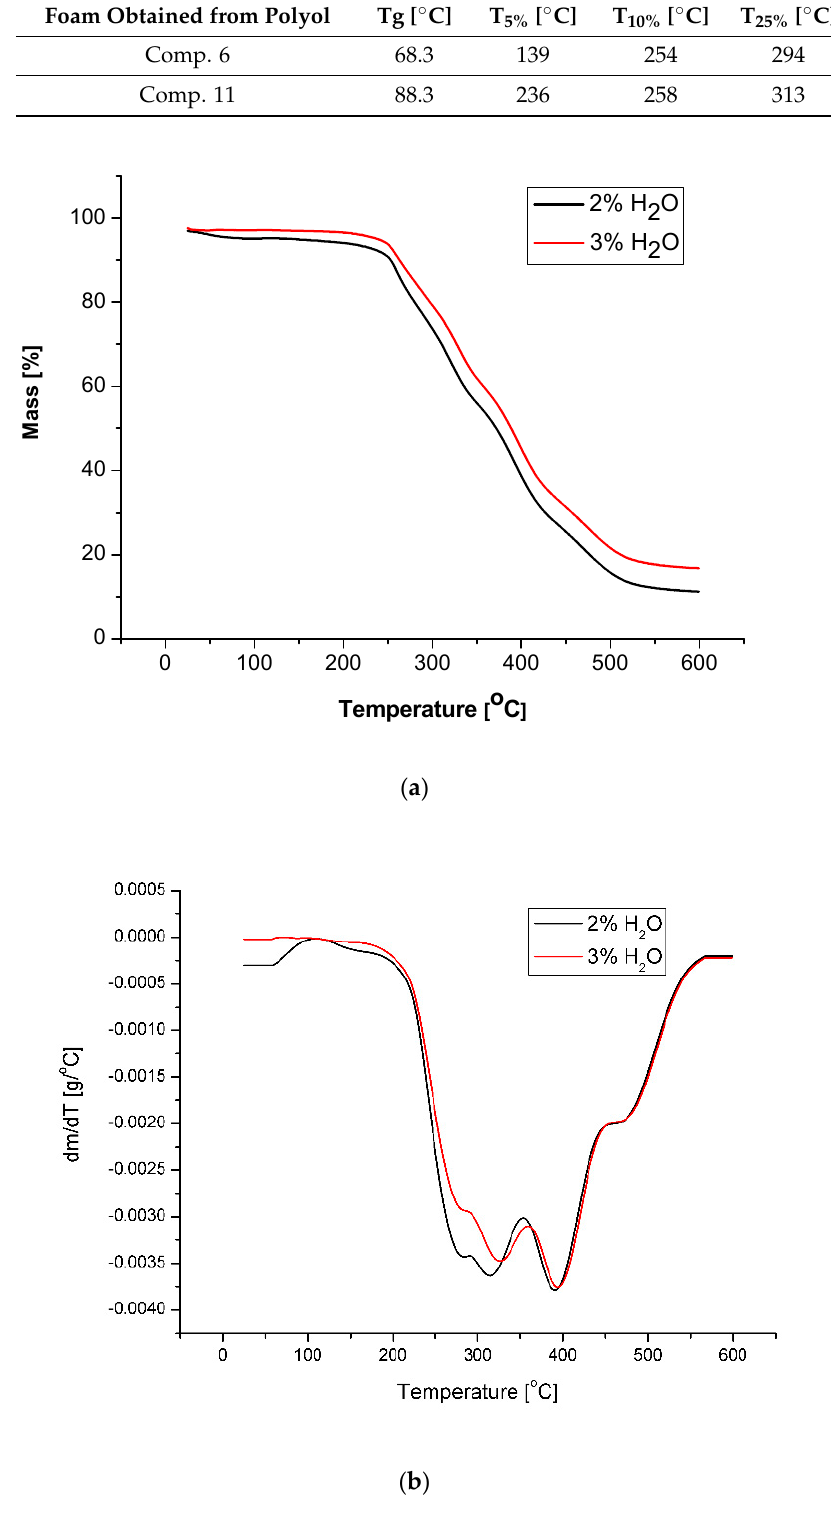
Figure 7. Thermal analysis of foams: mass change as a function of temperature ( a ), differential mass change as a function of temperature ( b